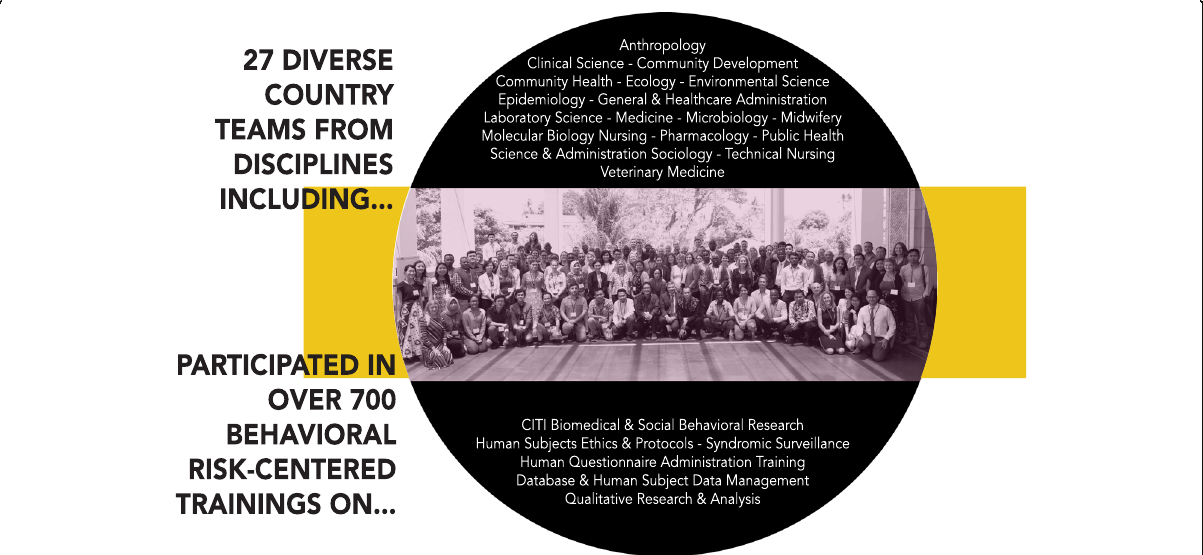
Fig. 3 Supporting the Creation of a Global Behavioral Risk Cadre. Bringing together a transdisciplinary team of scientists and practitioners was central to the human behavioral risk surveillance arm of PREDICT. Representing myriad disciplines, local behavioral risk teams were provided with trainings specifically centered on the foundations needed to successfully conduct behavioral risk investigations